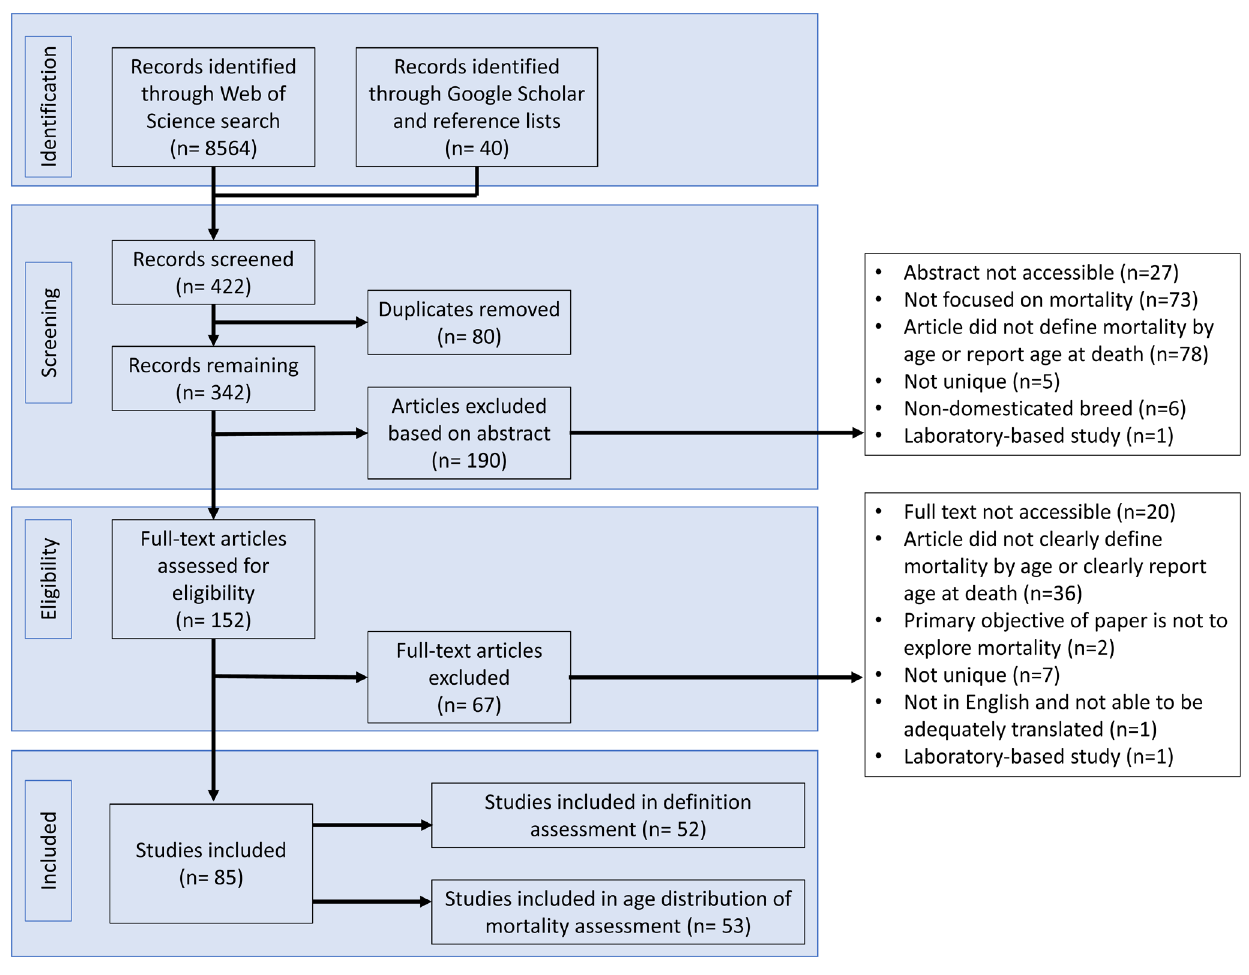
Figure 1. PRISMA flow chart for article screening and inclusion (adapted from Moher et al. , 2009). Of the 8604 articles identified by the literature search, 422 titles were assessed as relevant. Eighty duplicates were removed, before 190 articles were excluded based on their abstract contents. Sixty-seven articles were excluded on assessing the full text, leaving 85 articles for inclusion into the study.